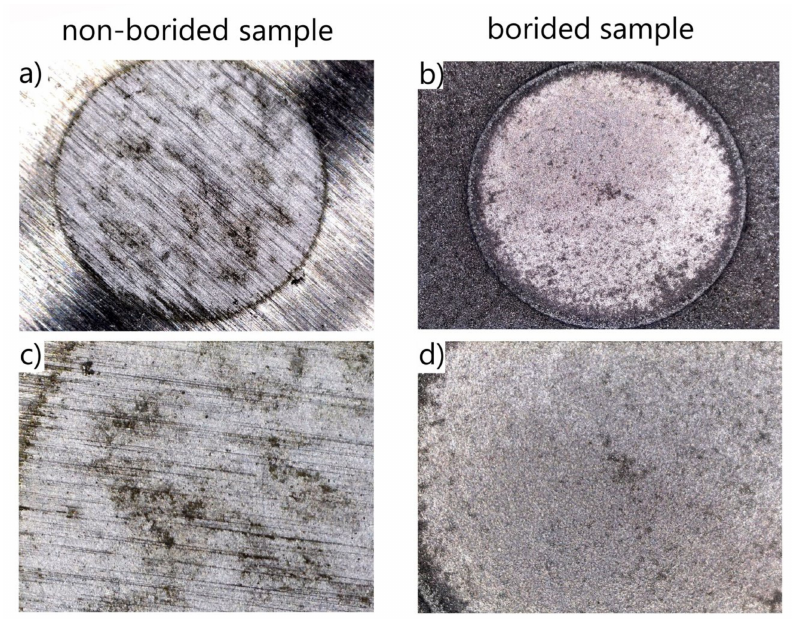
Figure 7. Macroscopic images of the corroded surfaces of non-borided ( a , c ) and borided ( b , d ) Nickel 201 after the corrosion resistance test in a 3.5% NaCl solution.